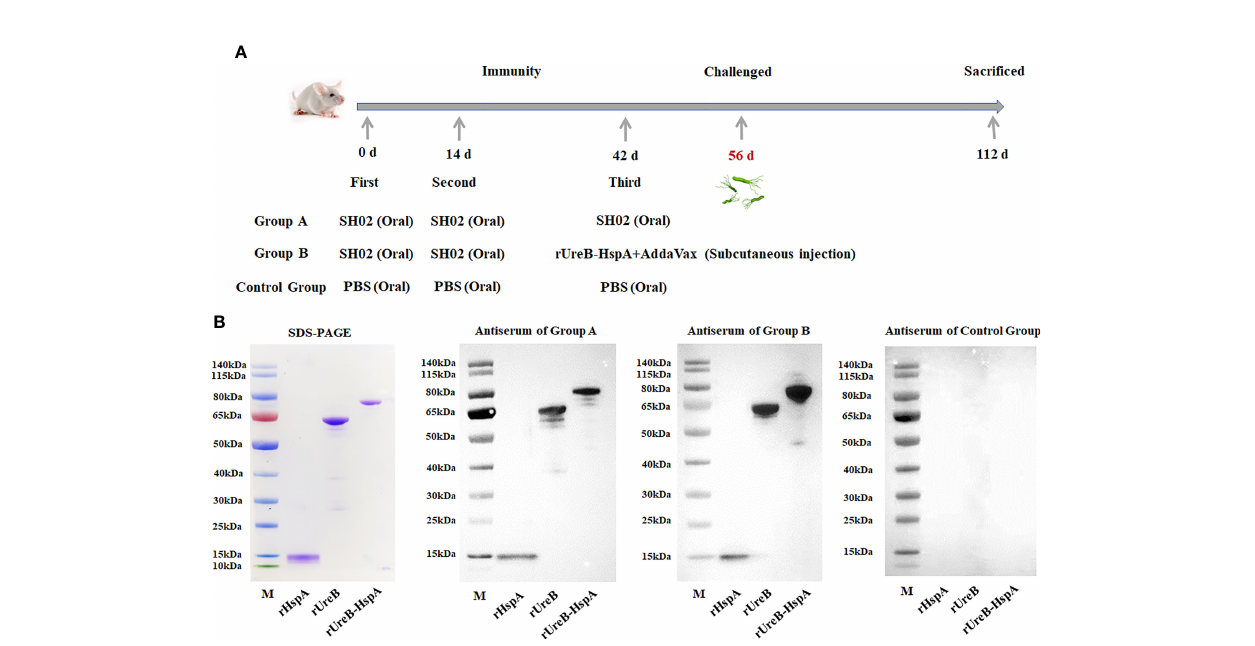
FIGURE 2 | Immunization schedule and antigen-speci fi c antibody detection. (A) Group A mice received oral administration of SH02 on days 0, 14, and 42; Group B mice received oral administration of SH02 on days 0 and 14, and subcutaneous injection of rUreB-HspA + adjuvant on day 42; oral administration of PBS three times served as a control group. Two weeks following the fi nal vaccination, the mice were infected with live H . pylori , and eight weeks later, they were sacri fi ced and samples were collected. (B) The antigen-speci fi c antibodies in the sera of immunized mice in the three groups before challenge were detected by Western Blot. M: Marker; Lane 1: rHspA; Lane 2: rUreB; Lane 3: rUreB-HspA.